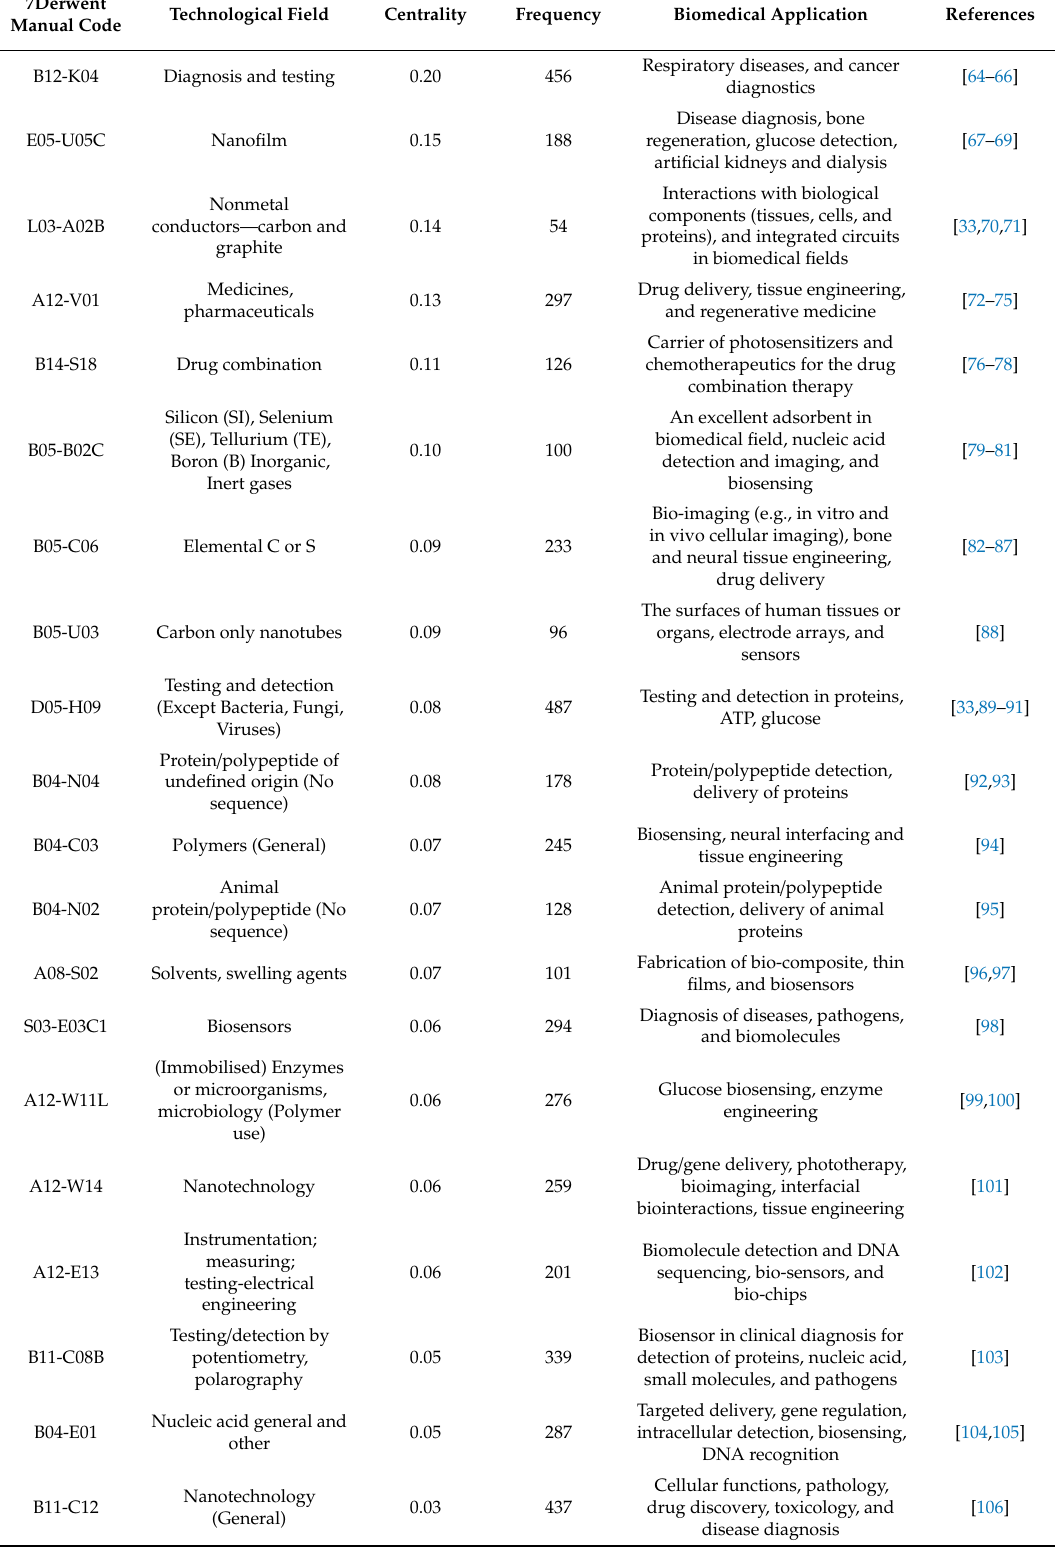
Table 2. Top 20 patent hotspots and fronts of graphene biomedical